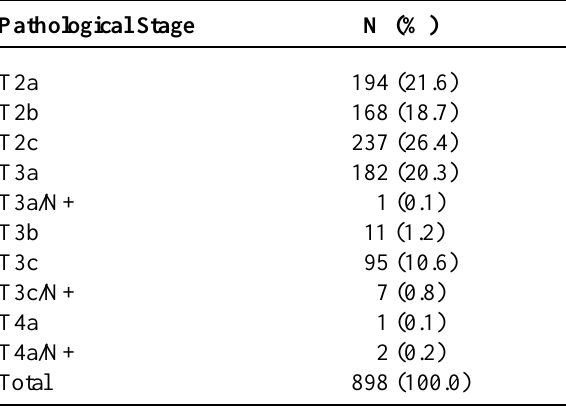
Table 2 – Patient distribution according to postoperative pathological stage.